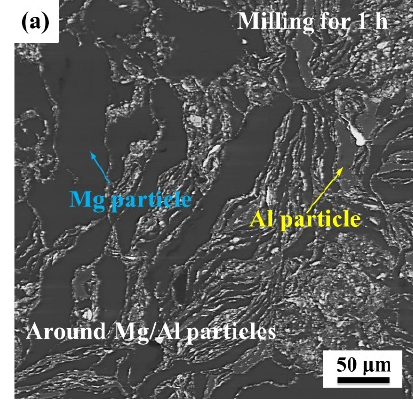
Figure 4. Microstructure of Mg-9Al-Zn-0.3Mn: ( a ) BSE image; ( b – e ) element distribution results; ( f – i ) EDS results of points A–D in ( a ).